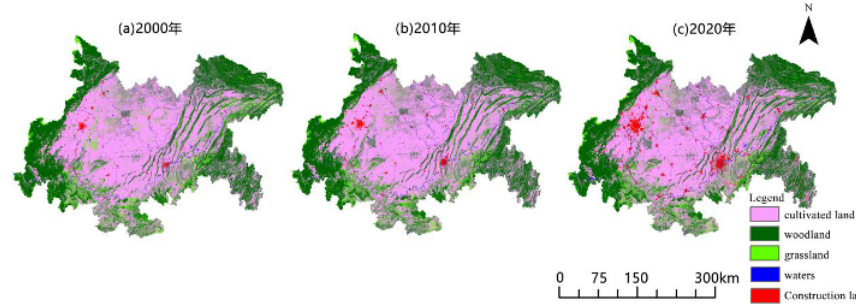
Fig. 2. Spatial distribution of land use in Chengdu-Chongqing urban agglomeration from 2000 to 2020.